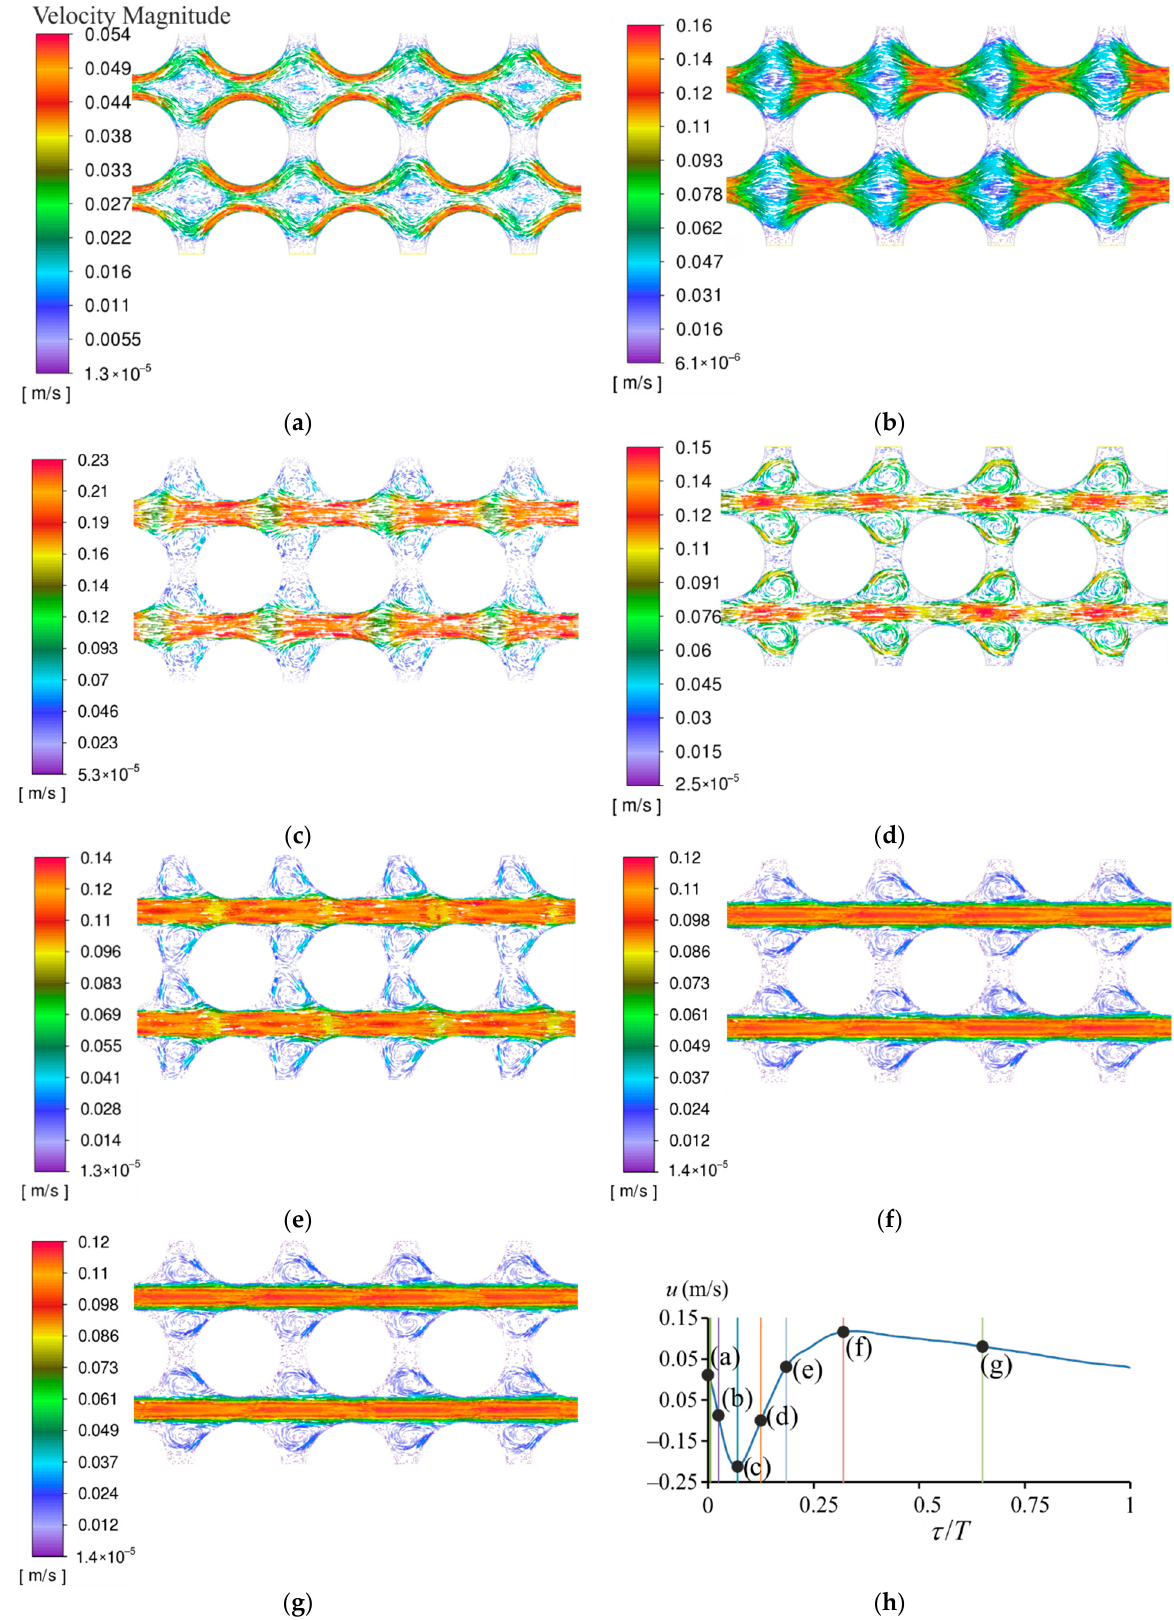
Figure 18. The instantaneous vector plots at different phases of pulsations for the three central rows of the tube bundle at A / D = 3, f = 0.5 Hz: ( a ) τ / T = 0.005 ( b ) τ / T = 0.025; ( c ) τ / T = 0.07; ( d ) τ / T = 0.125; € τ / T = 0.185; ( f ) τ / T = 0.32; ( g ) τ / T = 0.65. ( h ) The velocity at tube bundle inlet for one period of pulsations and seven phase